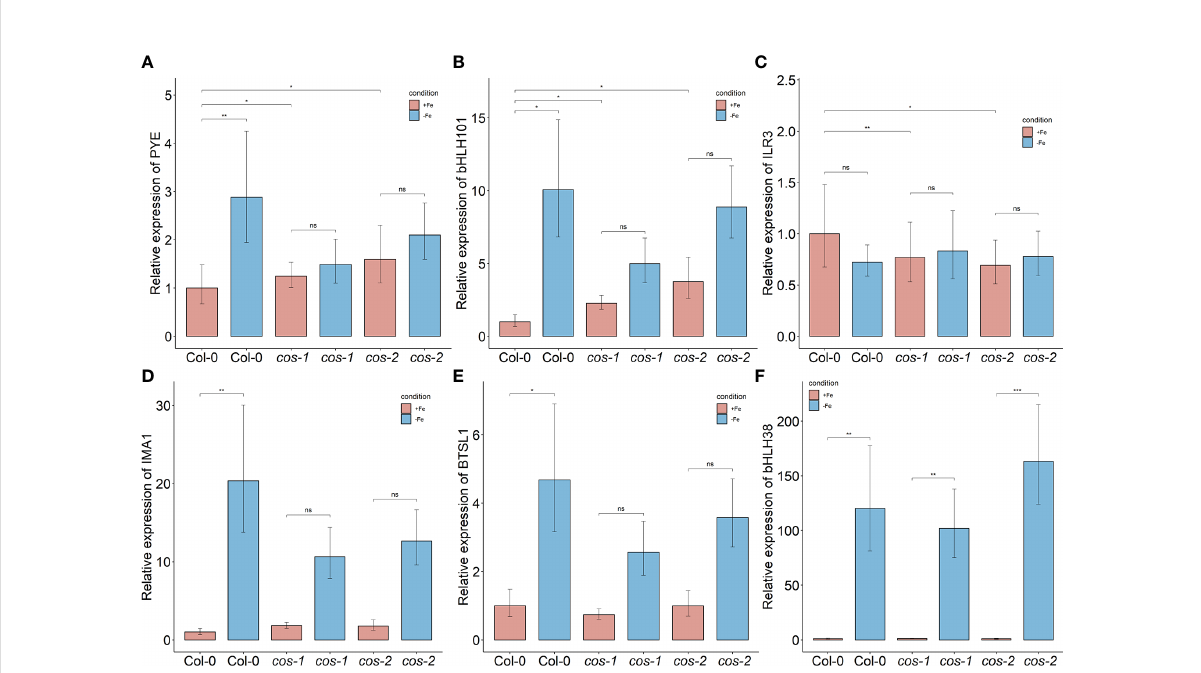
FIGURE 7 Expression of iron de fi ciency regulated genes in cos mutants. Expression levels of PYE (A) , bHLH101 (B) , ILR3/bHLH105 (C) , IMA1 (D) , BTSL1 (E) , and bHLH38 (F) transcripts in WT shoots and roots. Seedlings were grown on 1/2X MS agar with 50 m M Fe-EDTA for 14 d followed by a growth period of 3 d either on Fe-suf fi cient or Fe-de fi cient MS agar medium. Bars represent means ± SD of relative transcript levels normalized to ACT2 (n = 3). * represents p-value ≤ 0.01. ** represents p-value ≤ 0.001, *** represents p-value ≤ 0.0001, ns, not signi fi